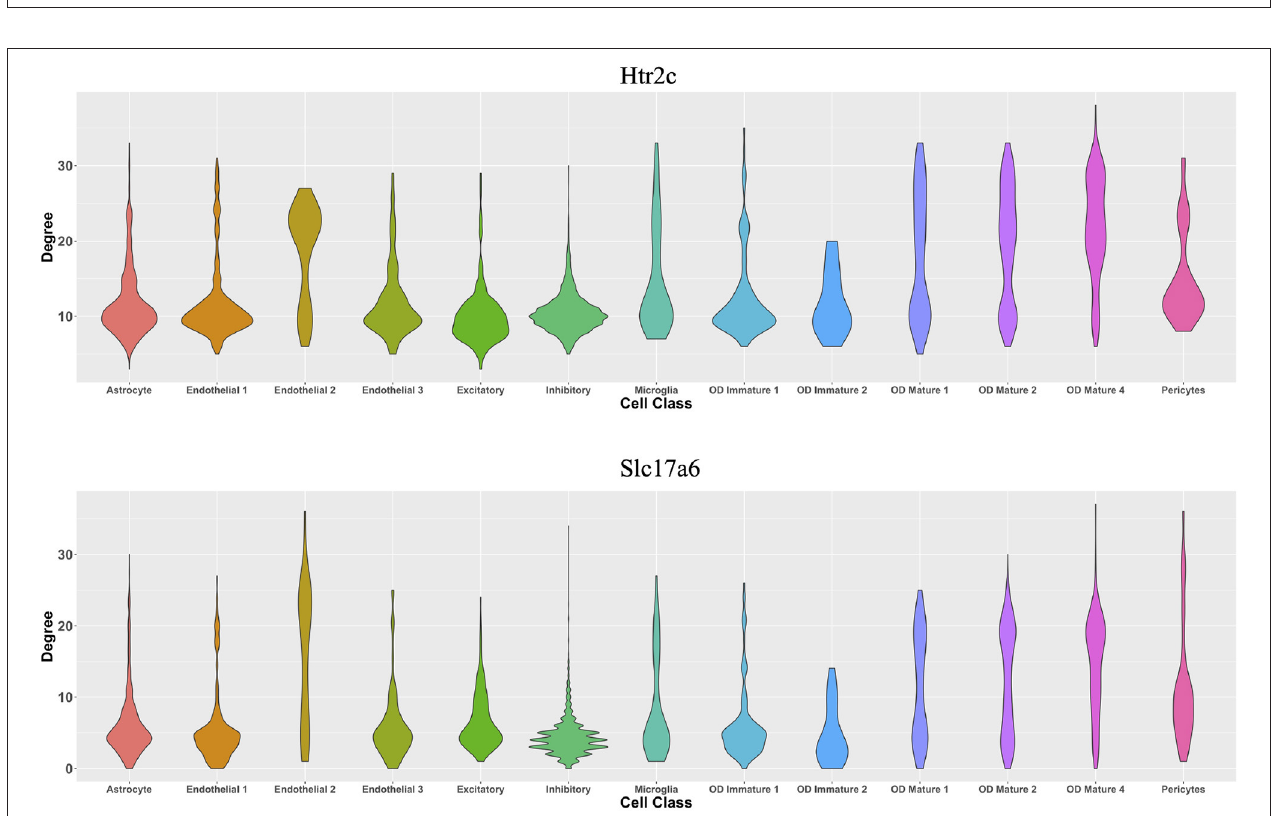
FIGURE 7 | Violin plots of two genes’ degree distributions across thirteen cell classes in the MERFISH mouse hypothalamus data.